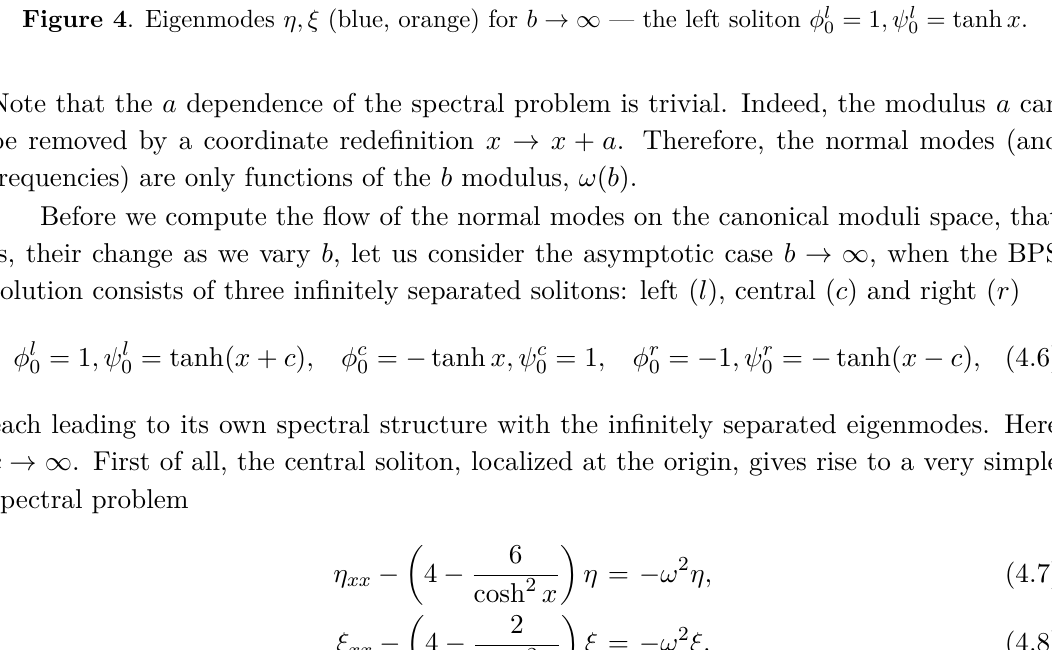
Figure 4 . Eigenmodes η, ξ (blue, orange) for b → ∞ — the left soliton φ l